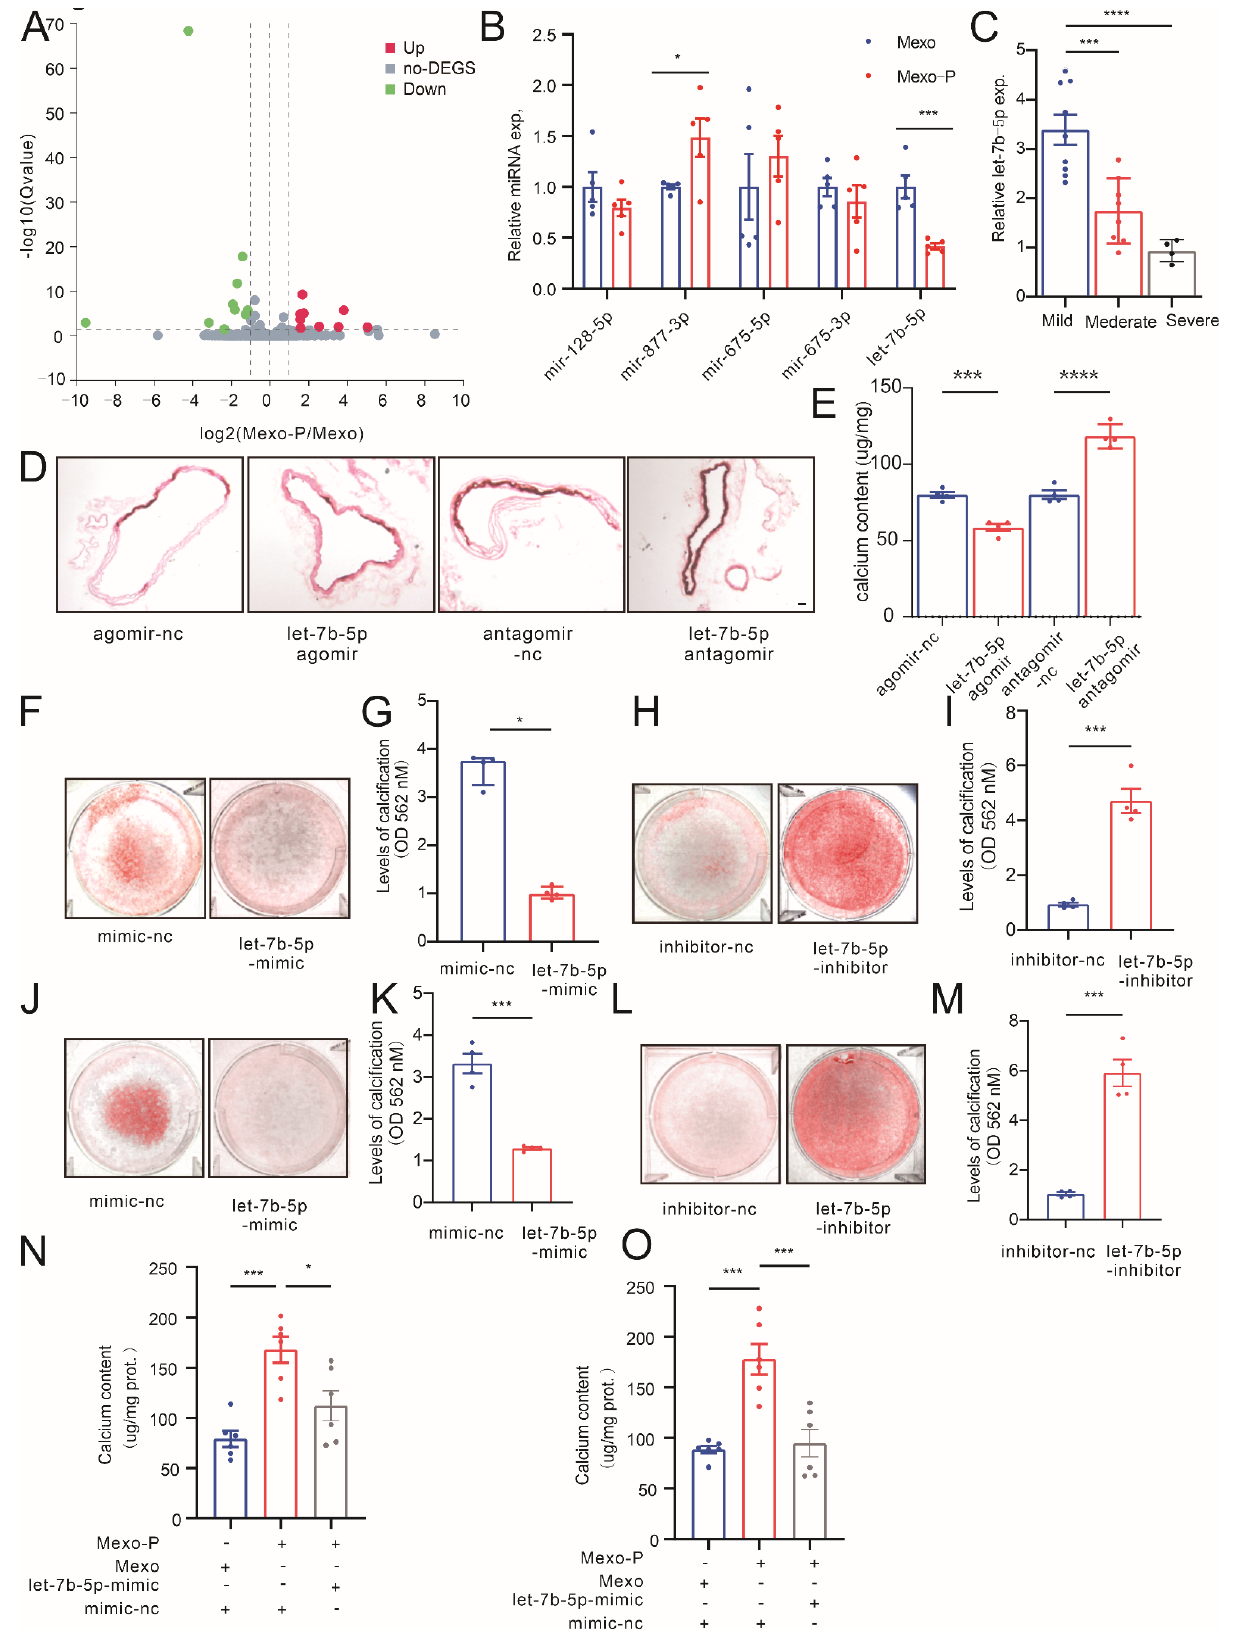
Figure 3. Mexo-P regulates vascular calcification in a let-7b-5p-dependent way. ( A ) Volcano